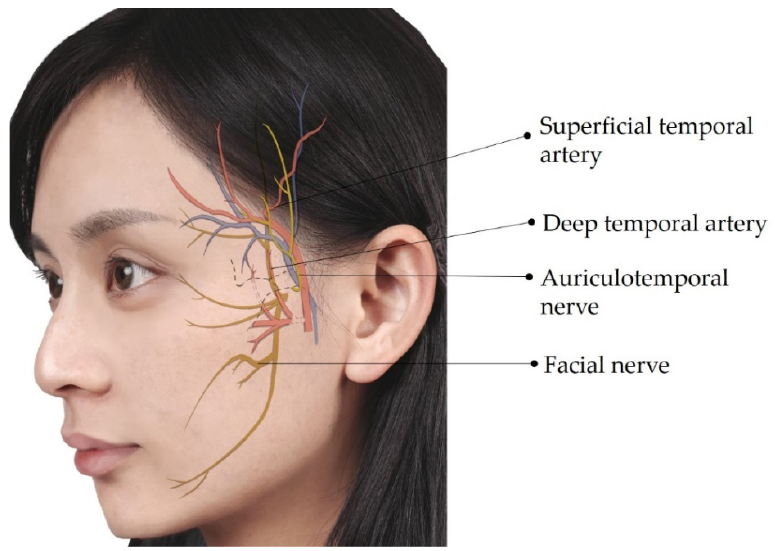
Figure 2. Illustration showing the lateral facial neurovascular structures. Blue structures indicate veins, which are mostly accompanied by arteries (in red) with the same nomenclature.